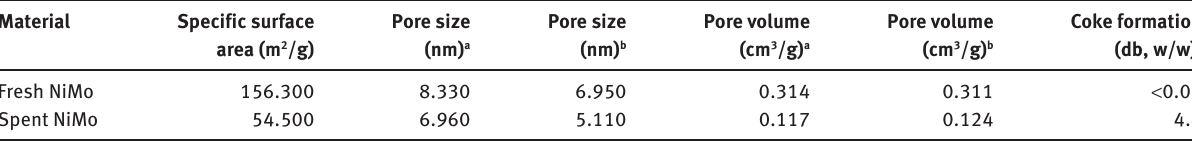
sorption using the BET method. 2